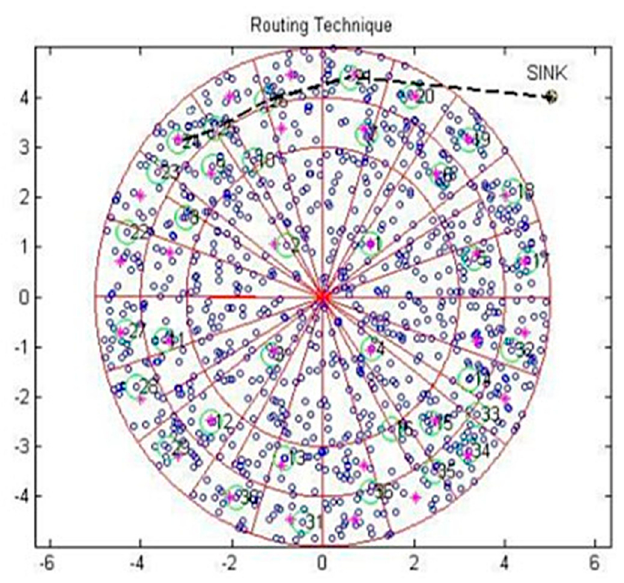
Figure 3. Routing for the RSC.